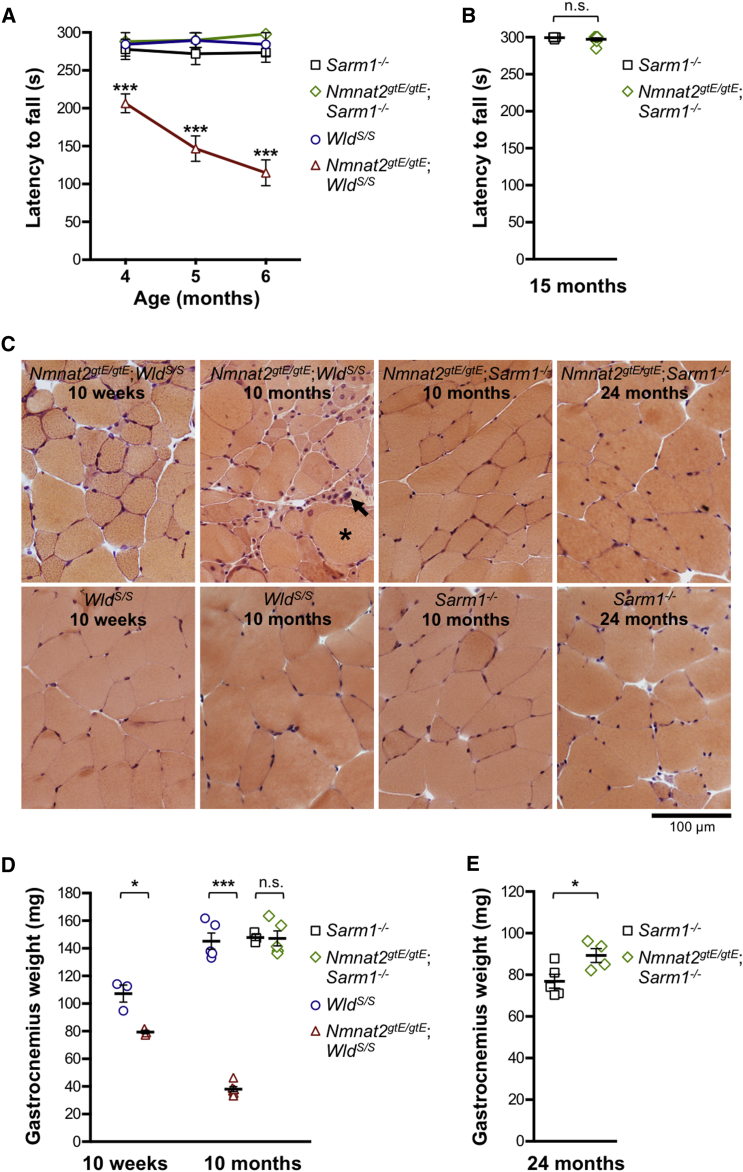
Progressive Locomotor Dysfunction and Hindlimb Muscle Atrophy in Nmnat2gtE/gtE;WldS/S Mice, but Not Nmnat2gtE/gtE;Sarm1−/− Mice(A and B) Latency to fall in an accelerating Rotarod task for mice of the indicated genotypes and ages. Means ± SEM are plotted (maximum test duration, 300 s) for n = 7/8 male mice of each genotype (A) (∗∗∗p < 0.001 in two-way ANOVA with Dunnett’s multiple comparisons) and n = 7 female mice of each genotype (B) (NS, not significant [p = 0.29] in t test).(C) Representative transverse sections of gastrocnemius muscle for mice of the selected genotypes and ages (as indicated) stained with H&E. Modest fiber atrophy is seen in Nmnat2gtE/gtE;WldS/S gastrocnemius at 10 weeks, and more severe atrophy, with centrally located nuclei, hypertrophic fibers (∗), and pyknotic nuclear clumps (arrow), is evident at 10 months. Images are representative of male and female mice at 10 weeks and 8–12 months but just female mice at 24 months.(D and E) Gastrocnemius muscle weights for mice of the indicated genotypes and ages. Individual animal values with means ± SEM are plotted for n = 3–5 male mice per group (D) (∗p < 0.05 and ∗∗∗p < 0.001 in one-way ANOVA with Tukey’s multiple comparisons; NS, not significant) and n = 4–5 female mice per group (E) (∗p < 0.05 in t test).See also Movies S1, S2, S3, S4, S5, and S6, Table S1, and Figure S1.